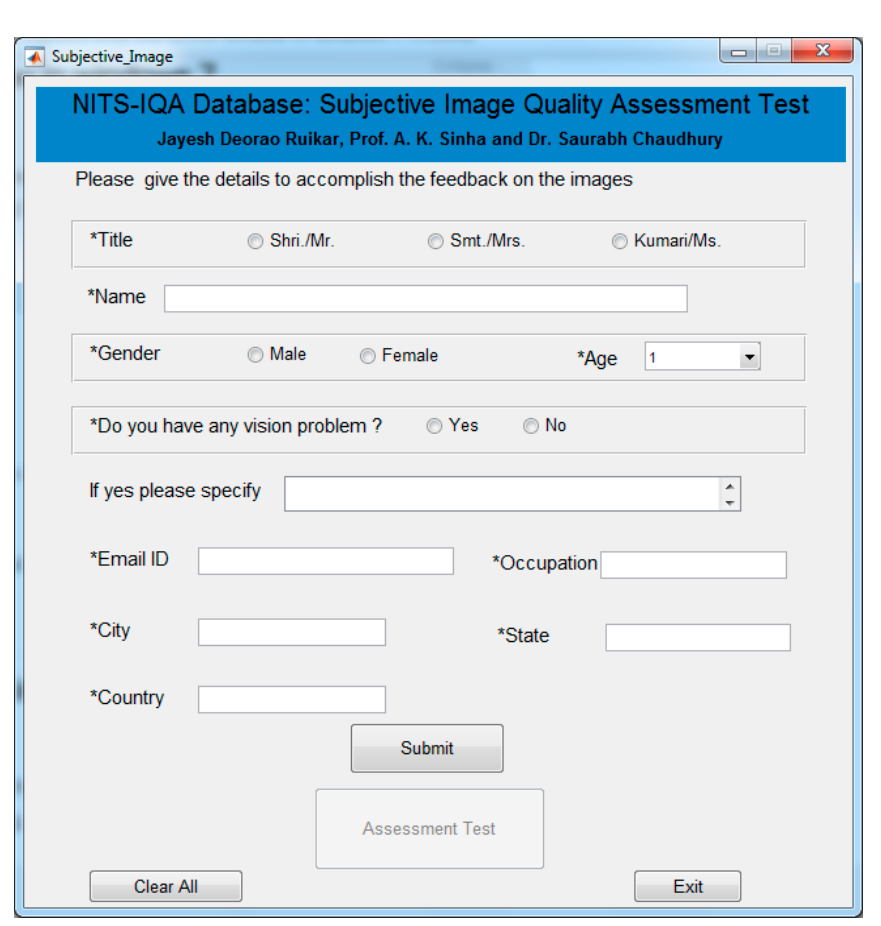
Figure 5. Graphical user interface (GUI)-1.